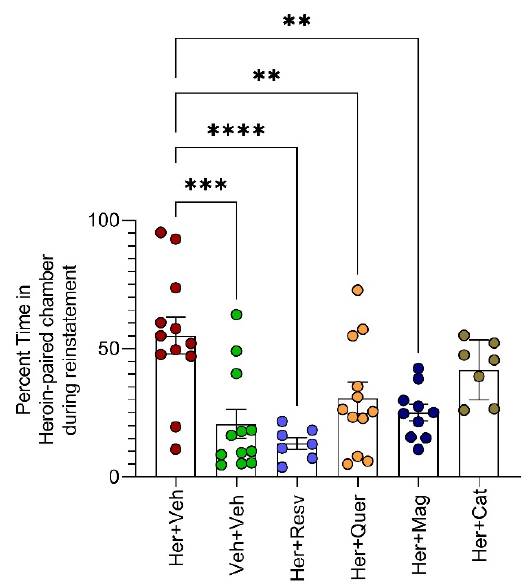
Figure 4. Resveratrol, quercetin, and magnolol prevent heroin-triggered reinstatement. A single heroin dose triggered reinstatement, as evidenced by the percentage of time spent in the heroin-paired chamber, as assessed by one-way ANOVA F(5, 54) = 6.983, p < 0.0001, [mean difference in percentage of time spent in heroin-paired chamber between heroin and vehicle groups = 34.40, 95% CI = 14.99 to 53.82, p = 0.0001]. Resveratrol [mean difference in percentage of time in heroin-paired chamber between heroin and heroin + resveratrol groups = 42.06, 95% CI = 19.45 to 64.68, p < 0.0001], quercetin [mean difference in percentage of time in heroin-paired chamber between heroin and heroin + quercetin groups = 24.36, 95% CI = 4.947 to 43.78, p = 0.008], and magnolol [mean difference in percentage of time in heroin-paired chamber between heroin and heroin + magnolol groups = 30.04, 95% CI = 9.682 to 50.41, p = 0.001] all prevented heroin-triggered reinstatement. However, β -catechin did not [mean difference in percentage of time in heroin-paired chamber between heroin and heroin + β -catechin groups = 13.40, 95% CI = − 9.222 to 36.01, p = 0.4], according to one way ANOVA followed by Dunnett’s multiple comparisons test against Her + Veh control group, n = 7–11 animals per group (** p < 0.01, *** p < 0.001, **** p < 0.0001). 3.3. Molecular Effects Resveratrol and magnolol attenuated the heroin-induced increase in striatal TNF- α concentration ( p < 0.001, p < 0.01 respectively), while resveratrol and β -catechin attenuated the heroin-induced increase in striatal IL-6 concentration ( p < 0.01, p < 0.001 respectively). On the other hand, quercetin accentuated IL-6 concentration ( p < 0.0001) (Figure 5).